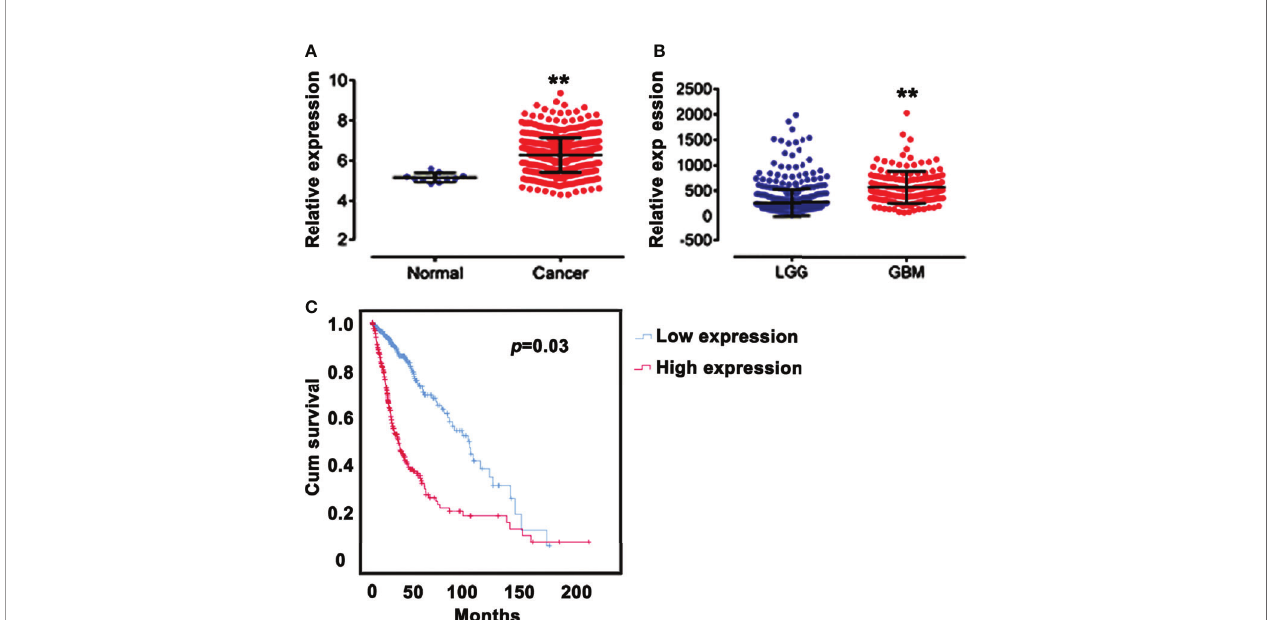
FIGURE 1 | SPAG5 expression is correlated with prognosis. (A) Relative expression of SPAG5 in normal (n = 10) and glioma tissues (n = 667). The SPAG5 mRNA expression pro fi le chip data including 667 glioma specimens and 10 normal specimens were all from TCGA database. vs Normal group, ** P < 0.01. (B) Relative expression of SPAG5 in low ‐ grade gliomas (LGGs, n = 515) and glioblastomas (GBM, n = 152). The SPAG5 mRNA expression data of 667 glioma specimens were from TCGA database. vs LGG group, ** P < 0.01. (C) Kaplan-Meier curves for glioma patients with low (n = 334) and high (n = 333) expression of SPAG5. According to the median, 667 glioma specimens from TCGA database were further divided into low SPAG5 expression group (n = 334) and high SPAG5 expression group (n = 333).